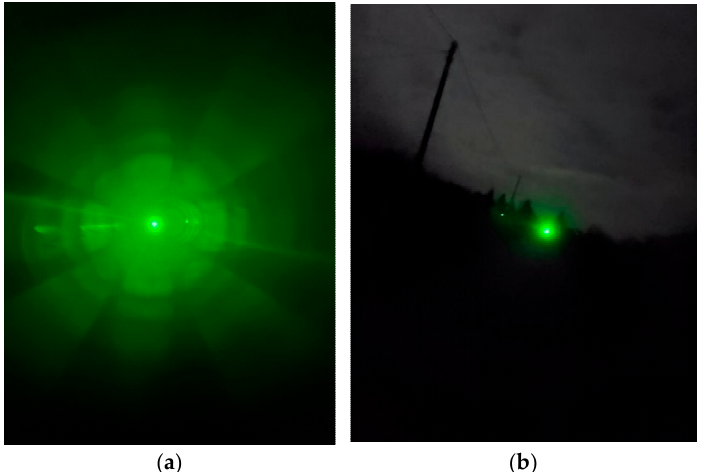
Figure 9. Frontal view of the green beam from 1.1 km ( a ). Green meter side view of the beam from 1.1 km ( b ).